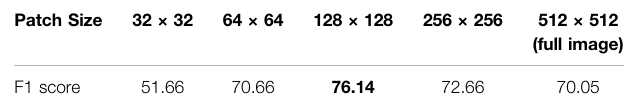
TABLE 2 | Average F1 scores for different patch